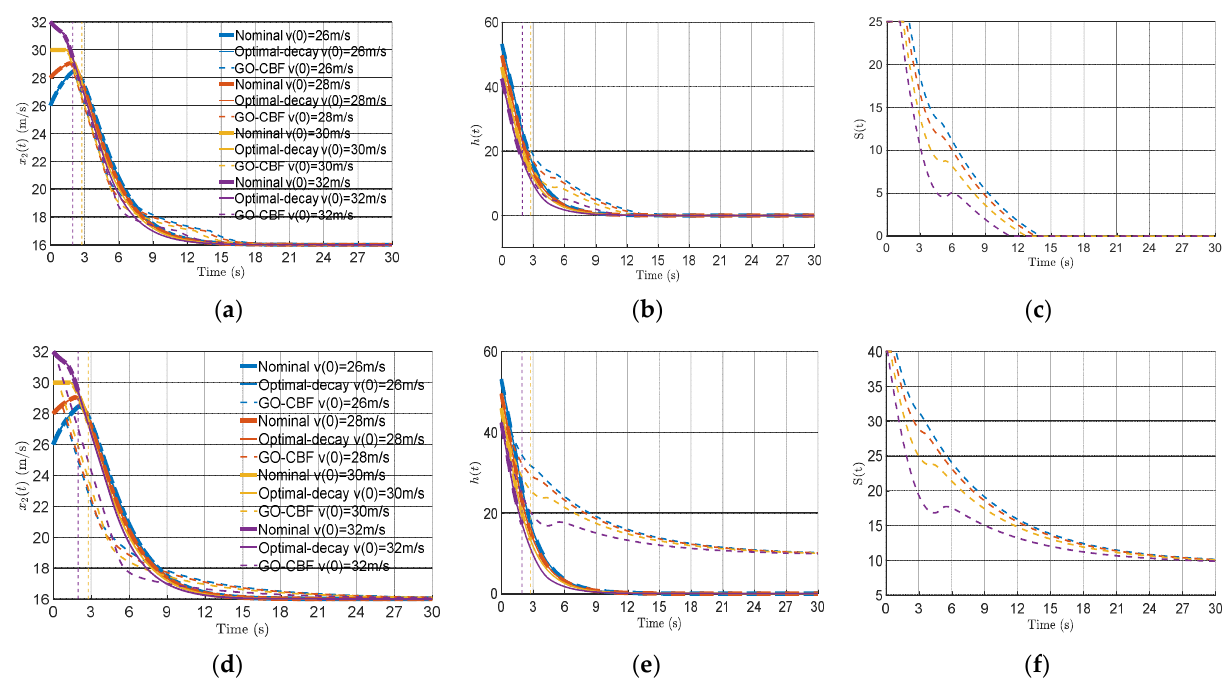
Figure 8. Simulation results of adaptive cruise control using fixed/optimal decay and our general and optimizable form of CLF-CBF-QP with different initial velocities. Different colors represent different initial conditions. For our general and optimizable form of CLF-CBF-QP, ( a – c ) are the results of S 0 = 25 and ( d – f ) are the results of S 0 = 40, while all of them use the same W S = 10 4 : ( a ) ego vehicle’s speed; ( b ) values of control barrier function; ( c ) actual safety margin; ( d ) ego vehicle’s speed; ( e ) the CBF h(x) values; ( f ) actual safety margin.